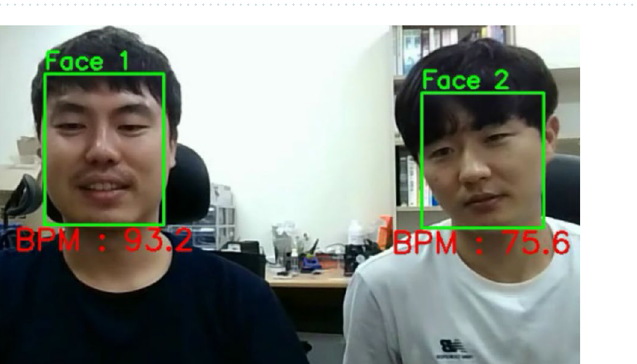
Figure 7. Comparison of the estimated HR results using our proposed method with and without the FSM framework. The HR is estimated using the proposed method, with detected noise removed by the FSM framework: ( a ) under the rapid head movement condition, ( b ) under the changes in ambient lighting condition.